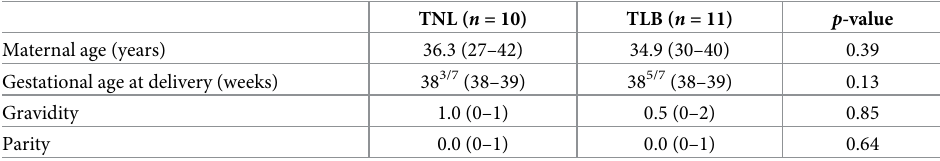
Table 1. Maternal characteristics of the study